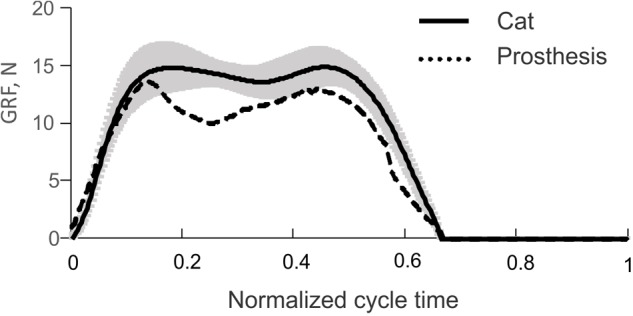
Vertical ground reaction force (GRF) recorded during level walking in the cat (solid line and shade, mean ± SD; computed using data from Prilutsky et al., 2011) and mean GRF recorded during the first three cycles of prosthesis testing (dashed line), see Figure 6A.